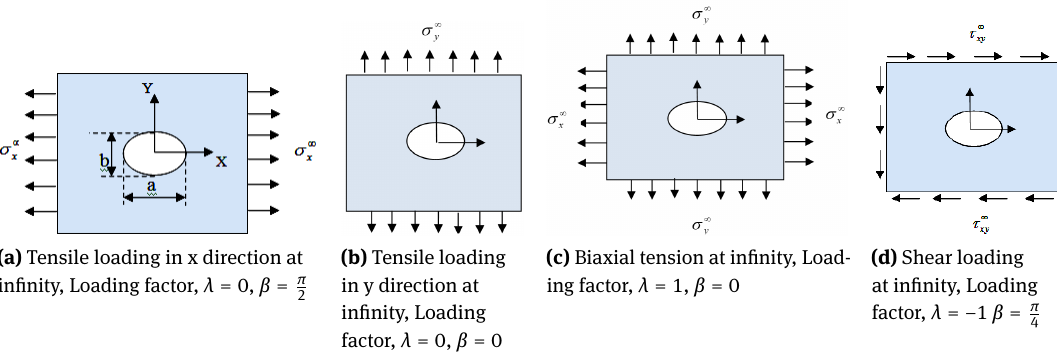
Figure 2: Loading factor λ and β for different in plane